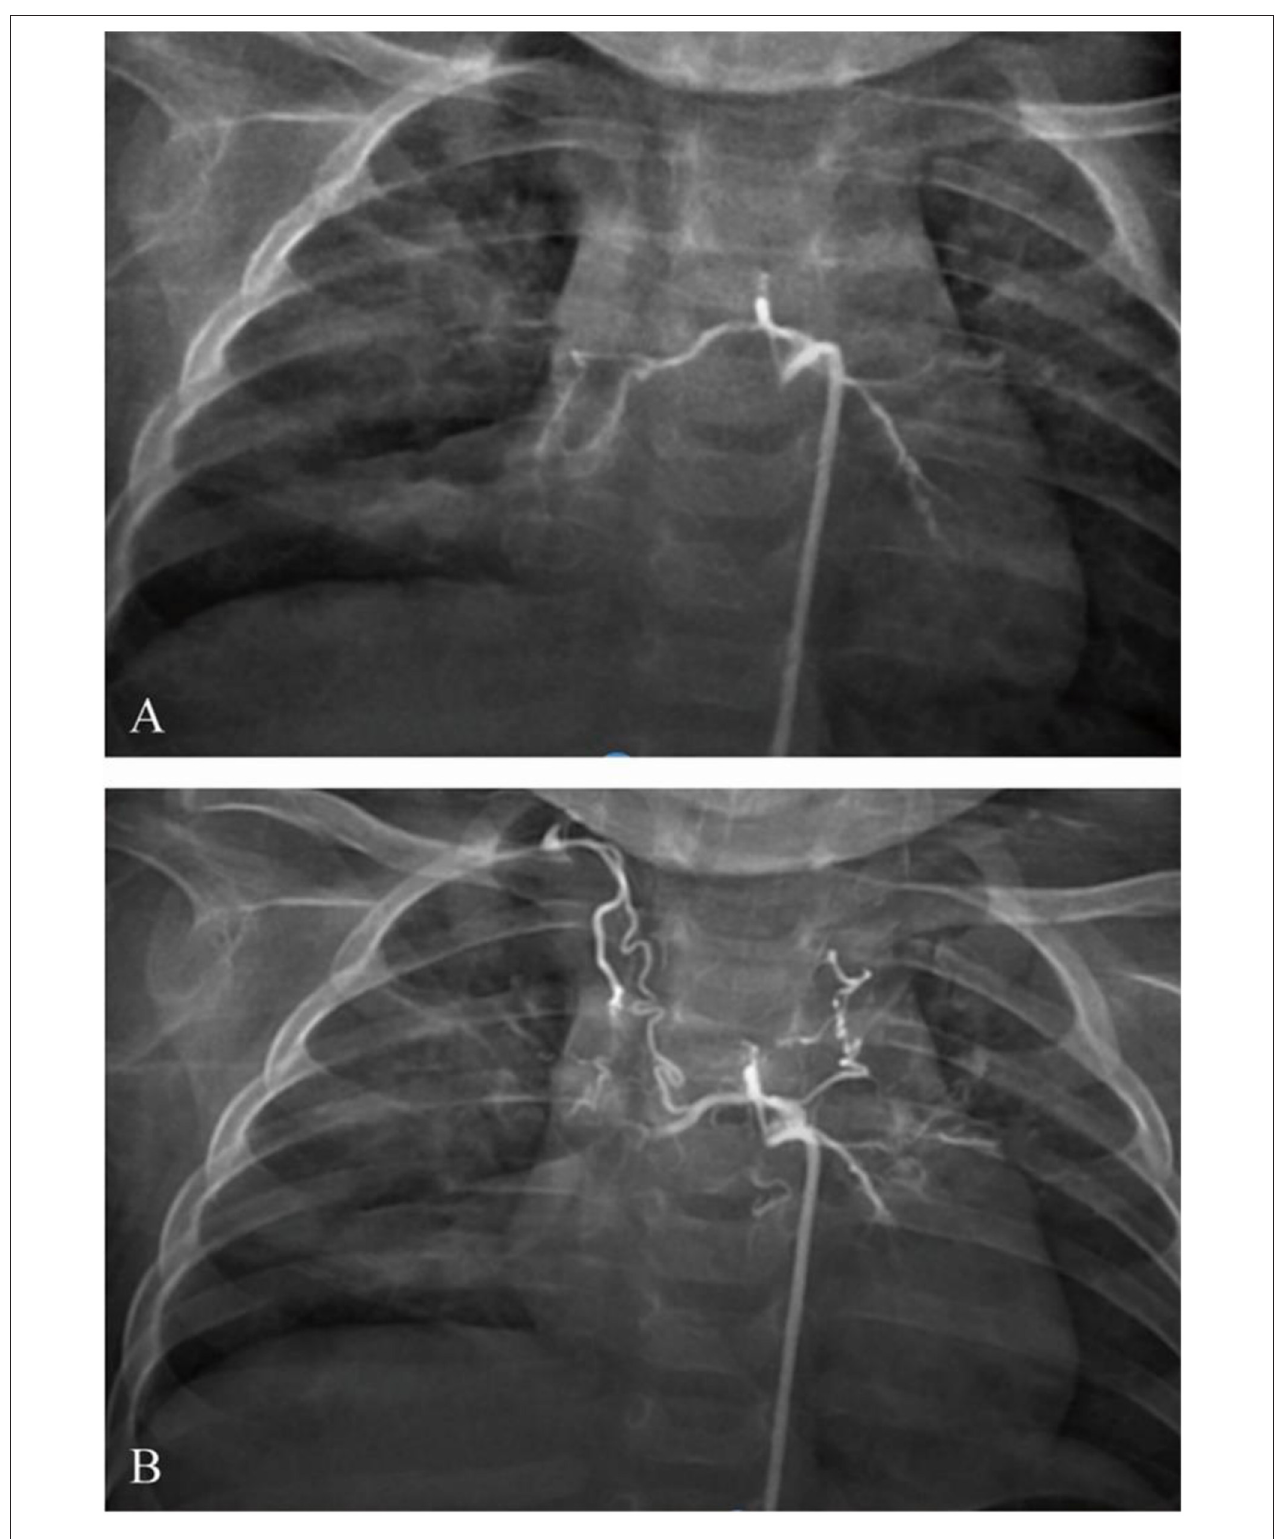
FIGURE 5 | Bronchial angiography (A) before and (B) after embolism.